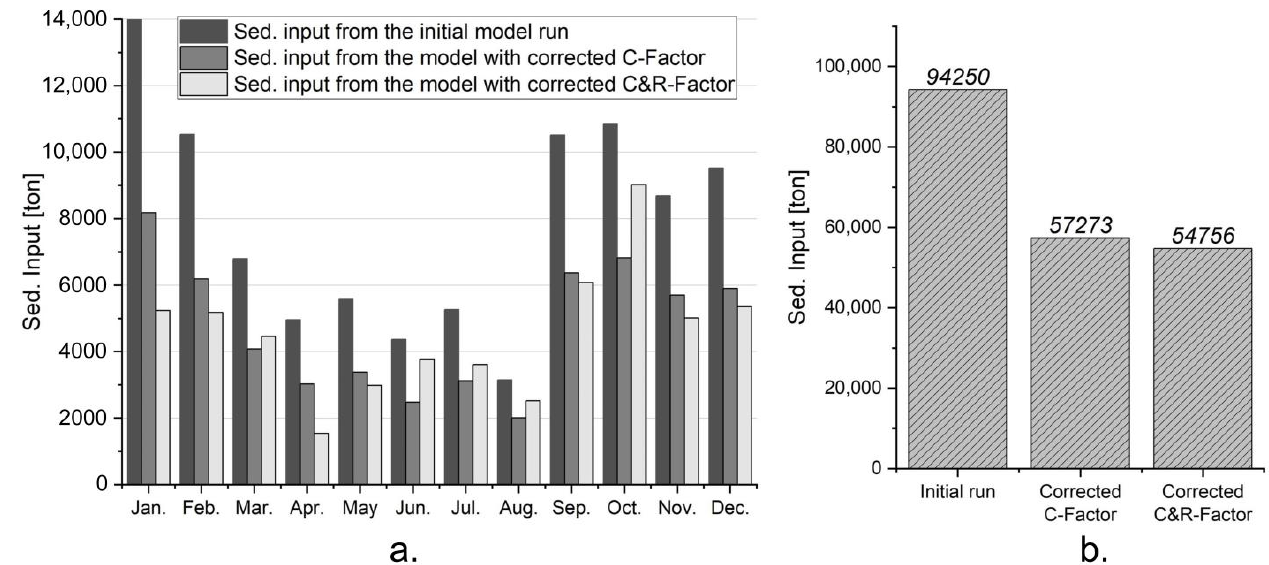
Figure 20. ( a ) Comparison of the interannual dynamics of the system ( b ). Comparison of the yearly sediment input.